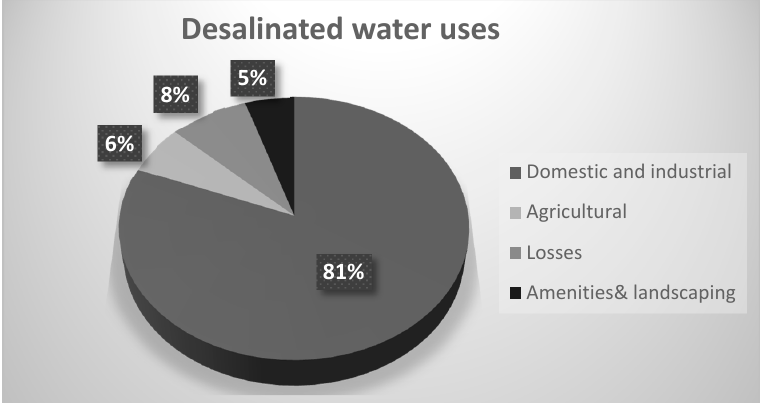
Figure 4. Desalinated water uses.